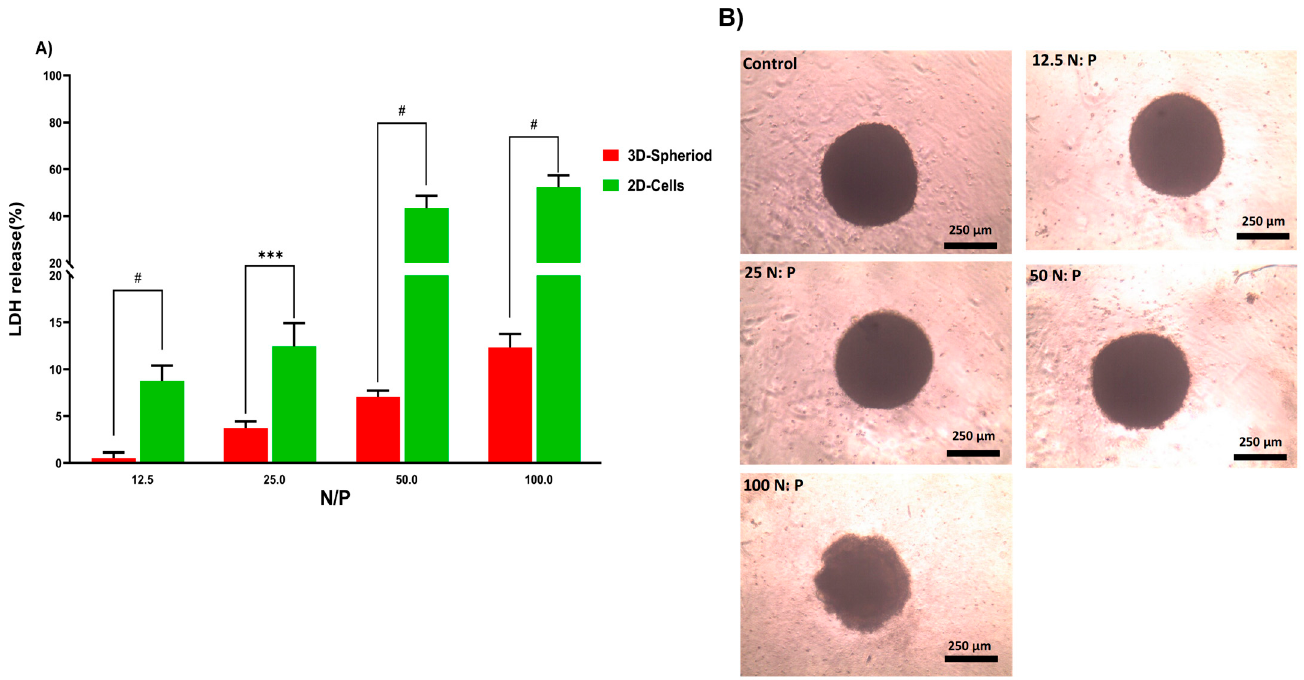
Figure 5. ( A ) Evaluation of LDH release from HT-29 2D and 3D spheroid cells after 24 h exposure to PPoly–pDNA complexes at 12.5, 25, 50, and 100 N/P ratios. ( B ) The incubation of spheroids with different ratios of PPoly–pDNA complexes contributing to the loss of spheroid integrity and structure. One-way ANOVA with Tukey post hoc analysis was conducted. *** p < 0.001 and # p <